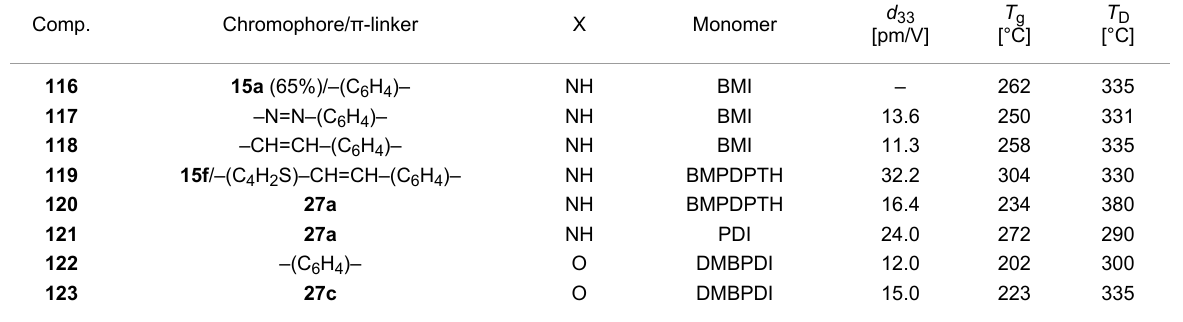
Table 14: Nonlinear optical polymers 116 – 123 ; properties [18,50-53,122-124]. Comp.